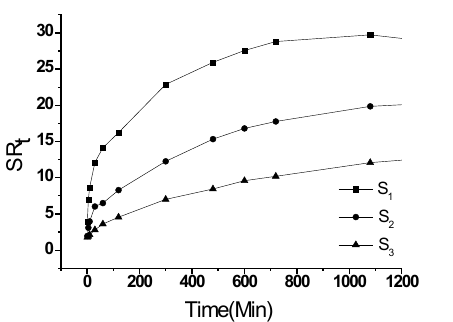
Figure 4. LCST of hydrogels with different NIPAAm/Am molar ratios.